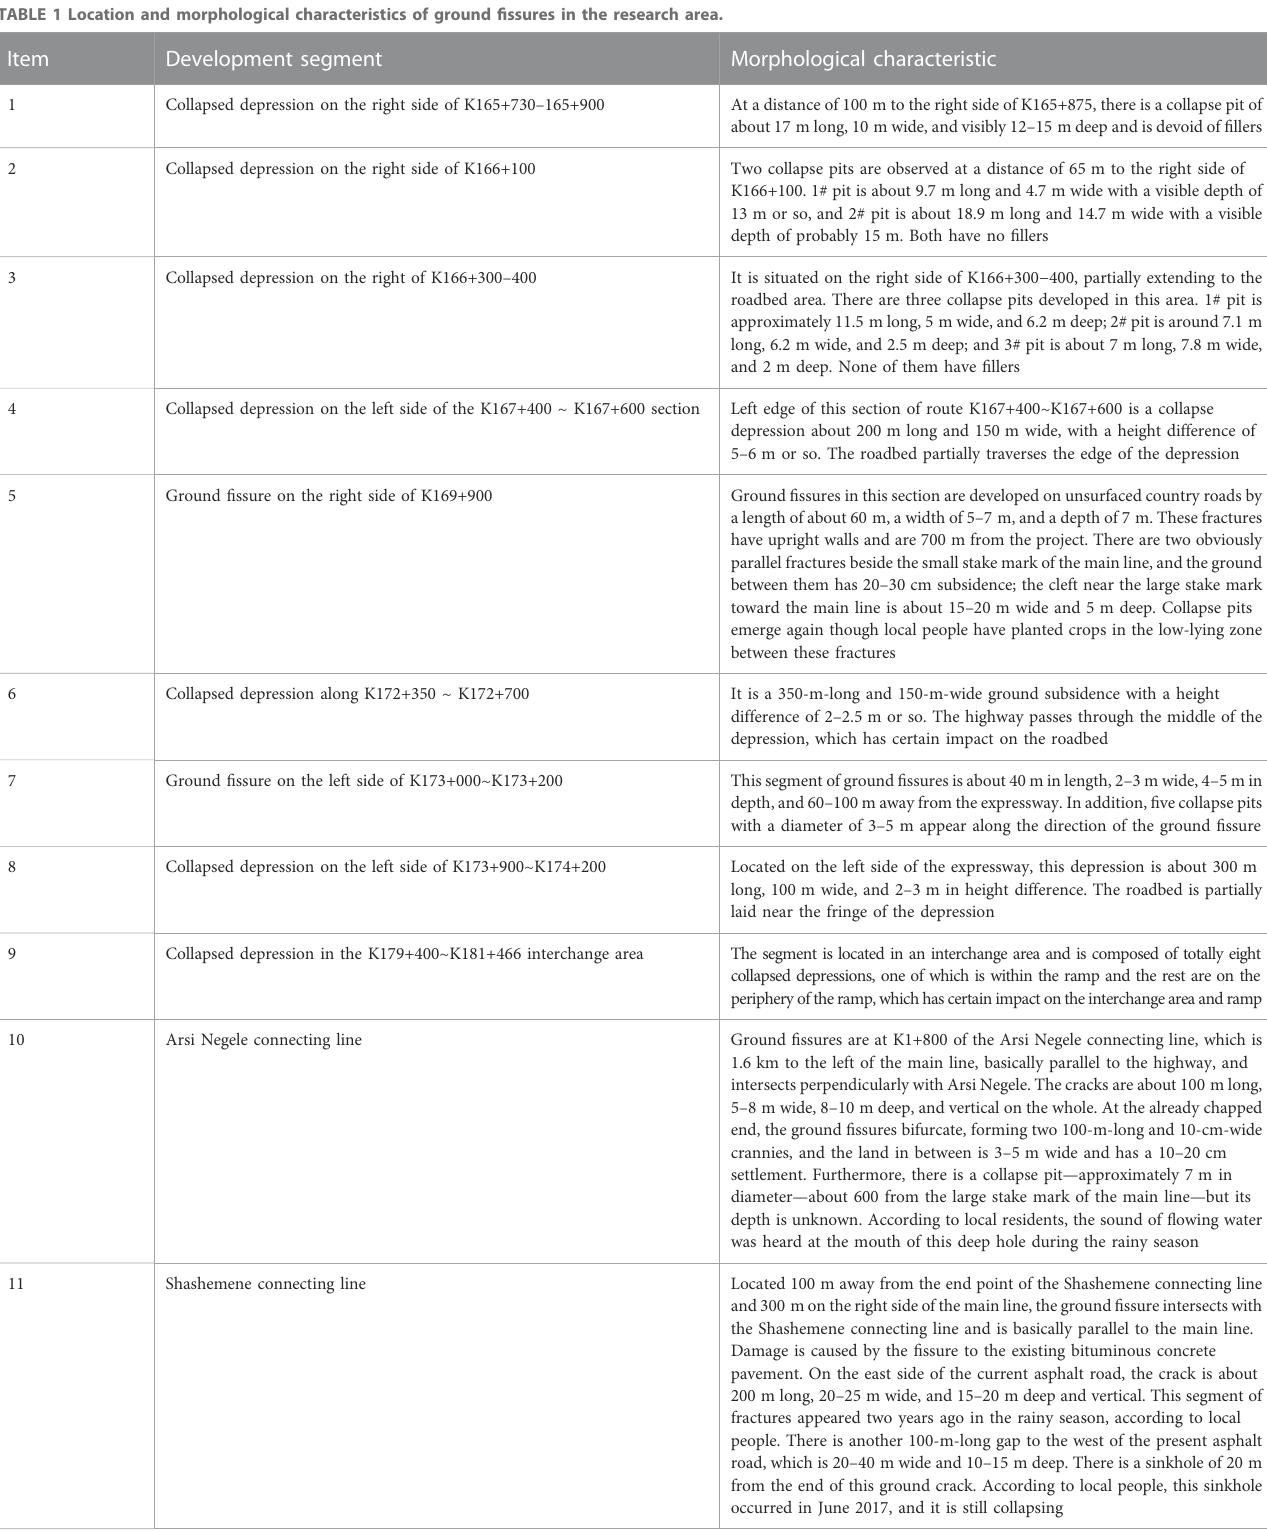
TABLE 1 Location and morphological characteristics of ground fi ssures in the research